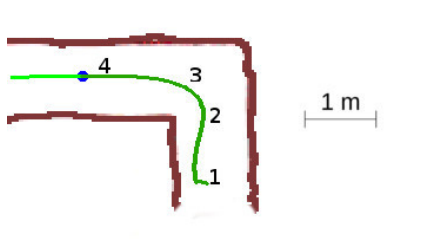
Figure 13. Unexplored corner